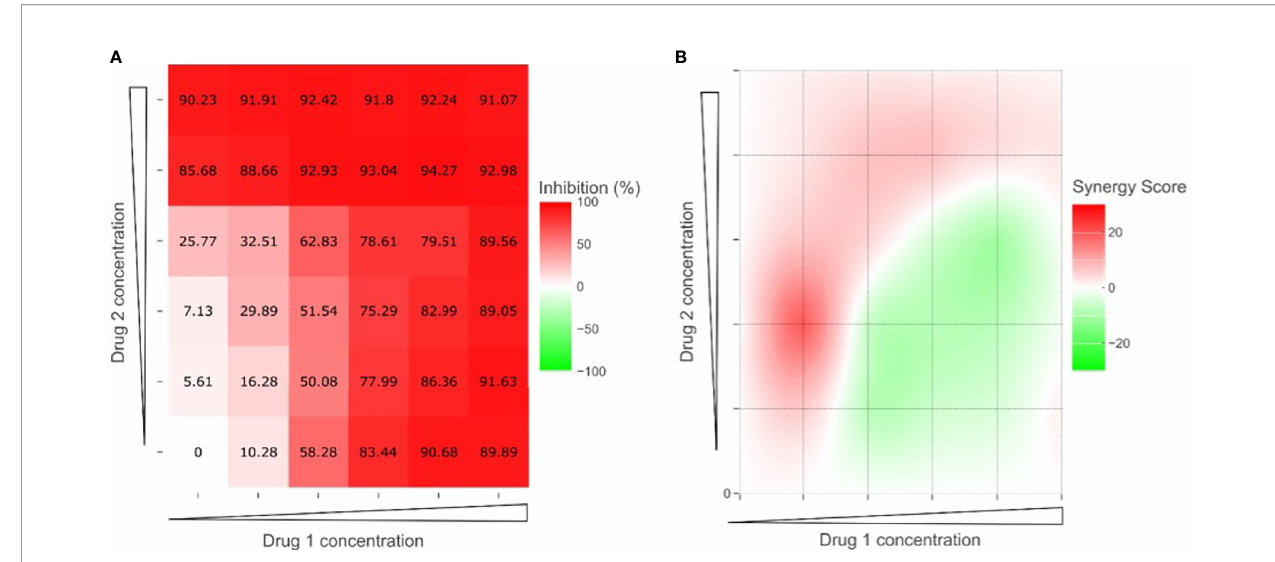
FIGURE 1 | SynergyFinder Plus analysis for an example of two-drug combinations. (A) Dose-response matrix calculated as percentage of growth inhibition. (B) Synergy distribution map; red indicates synergy (synergy score > 0) and green indicates antagonism (synergy score <